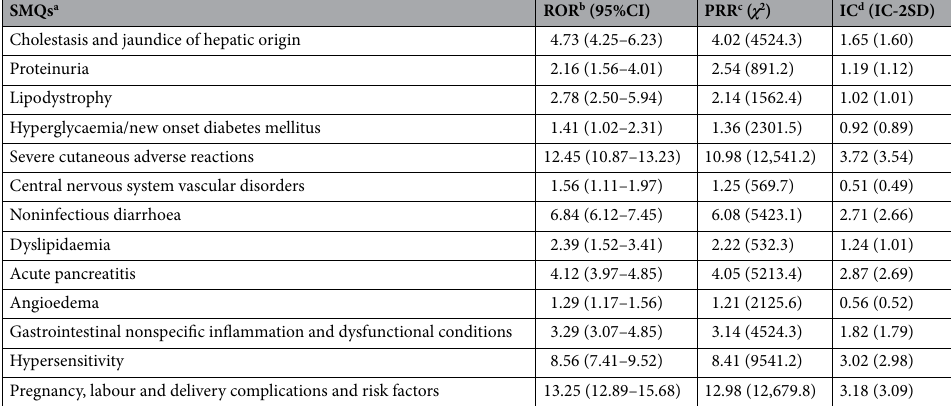
Table 3. Signal strength for darunavir and its boosted agents at the SMQ level in FAERS. a SMQs standardized MedDRA queries. b ROR reporting odds ratio. The lower limits of the 95% CI of the ROR greater than 1 indicated statistically significant RORs. c PRR proportional reporting ratio. PRR and χ 2 greater than 2 and 4 respectively indicated statistically significant PRRs. d Information component. The signal was statistically significant when IC-2SD >